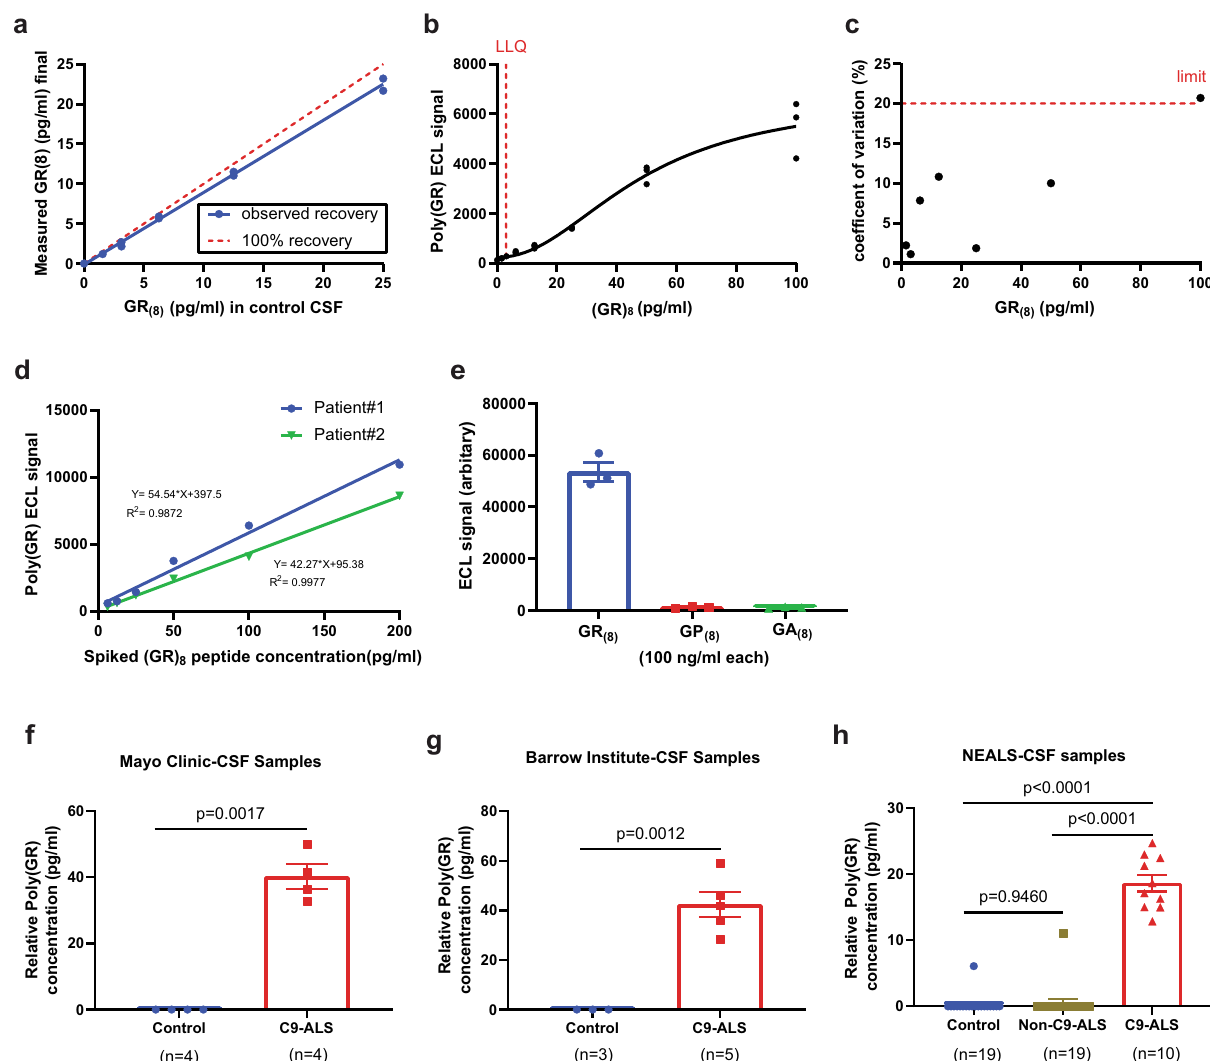
Fig. 1 Blinded measurement of poly(GR) levels in CSF in multiple cohorts of patients with C9ORF72 mutations using the MSD-based poly(GR) immunoassay. a In spike-and-recovery experiments, recombinant (GR) 8 peptide was added to CSF from healthy individuals and subsequently serially diluted into a separate tube containing CSF from healthy individuals to create a 5-point series. The average recovery rate in two different samples was 81 – 88%. b The assay can detect puri fi ed (GR) 8 peptide at concentrations as low as 3 pg/ml. Replicates of 8-point series standard curve run on different dates are shown. A four-parameter logistic curve was used to fi t the dose-response with GraphPad Prism 9.1. c Across the dynamic range of the assay, the coef fi cient of variation is less than 16% for all points except one concentration (100 pg/ml), below the 20% cutoff recommended by the FDA in standard variability for liquid-binding assays. d Dilution linearity was evaluated by measuring duplicates of 5 dilutions of 2 patient CSF samples spiked with 200 ng/ ml (GR) 8 peptide. e Poly(GR) immunoassay speci fi cally detects (GR) 8 peptide in control CSF and did not cross react with even up to 100 ng of (GP) 8 peptide in control CSF, n = 3 independent experiments, values are mean ± s.e.m. f CSF samples from 4 healthy and 4 patients with C9ORF72 mutations from the Mayo Clinic, Florida, values are mean ± s.e.m ( p = 0.0017, Unpaired t -test with Welch ’ s correction). g CSF samples from 3 healthy people from the NEALS cohort and 5 CSF samples from two patients with C9ORF72 mutations from the Barrow Institute, Arizona, values are mean ± s.e.m ( p = 0.0012, Unpaired t -test with Welch ’ s correction). h 19 healthy people, 19 patients with ALS but without C9ORF72 mutations (3 patients with duplicate samples, 16 patients with single samples), and 10 patients with C9ORF72 mutations (8 patients with duplicate samples, 2 patients with single samples) from the NEALS Consortium. Values from duplicate samples are presented as mean ± s.e.m ( p = 0.9460 control vs non-C9-ALS, p < 0.0001 non-C9-ALS vs C9-ALS, p < 0.0001 control vs C9-ALS Ordinary one-way ANOVA-Tukey ’ s multiple comparisons test). Source data are provided as a Source Data fi le.